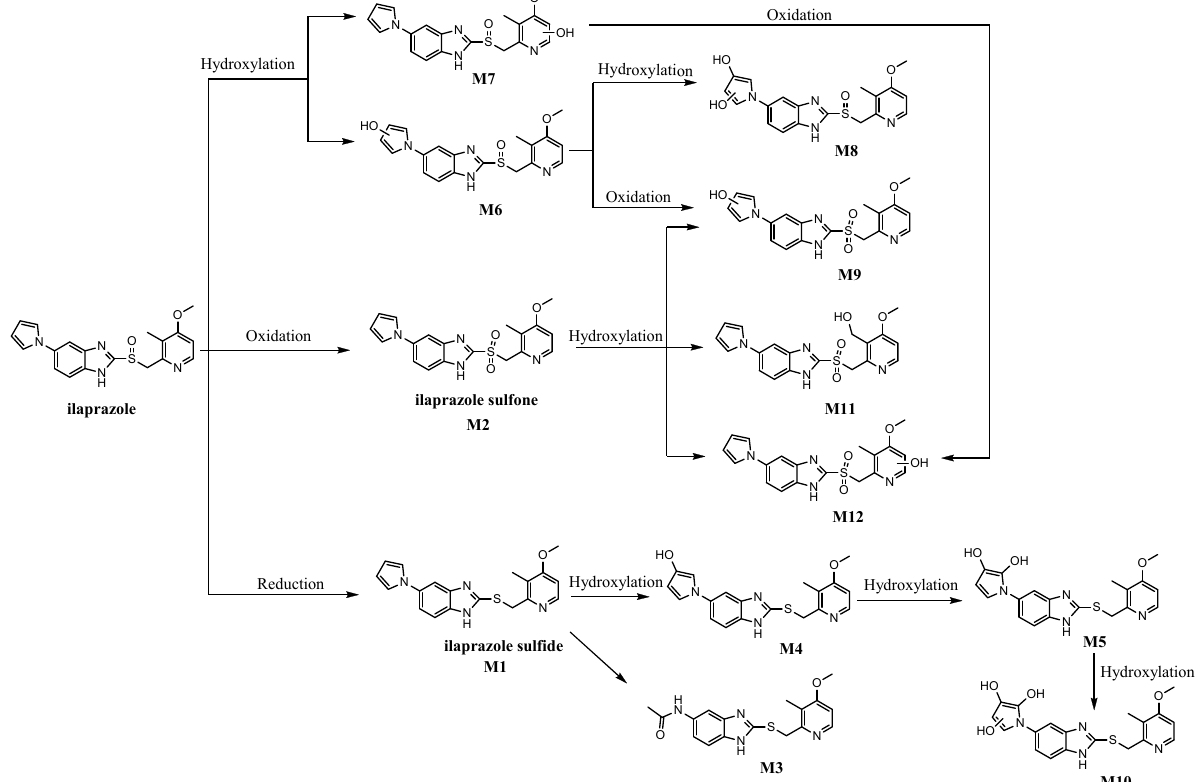
Figure 1. The metabolites of ilaprazole and the possible metabolic pathways in rats.